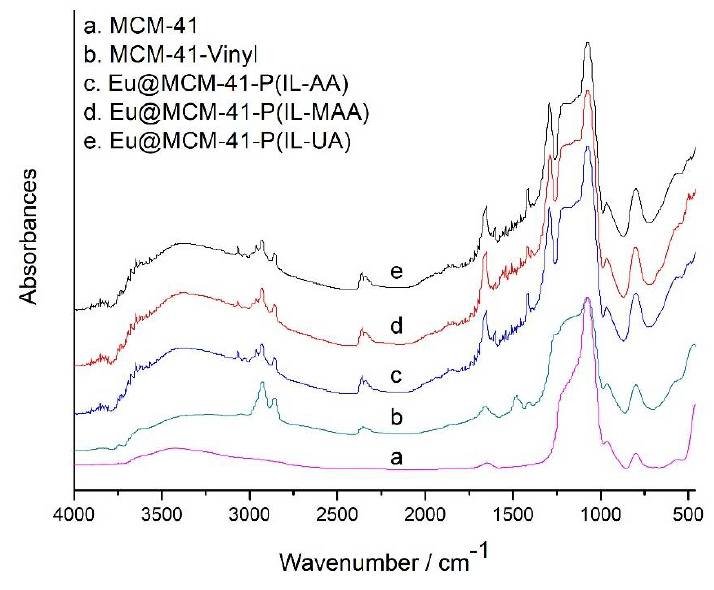
Figure 2. FTIR spectra of MCM-41, vinyl-modified MCM-41 (MCM-41-Vinyl), and the final materials.